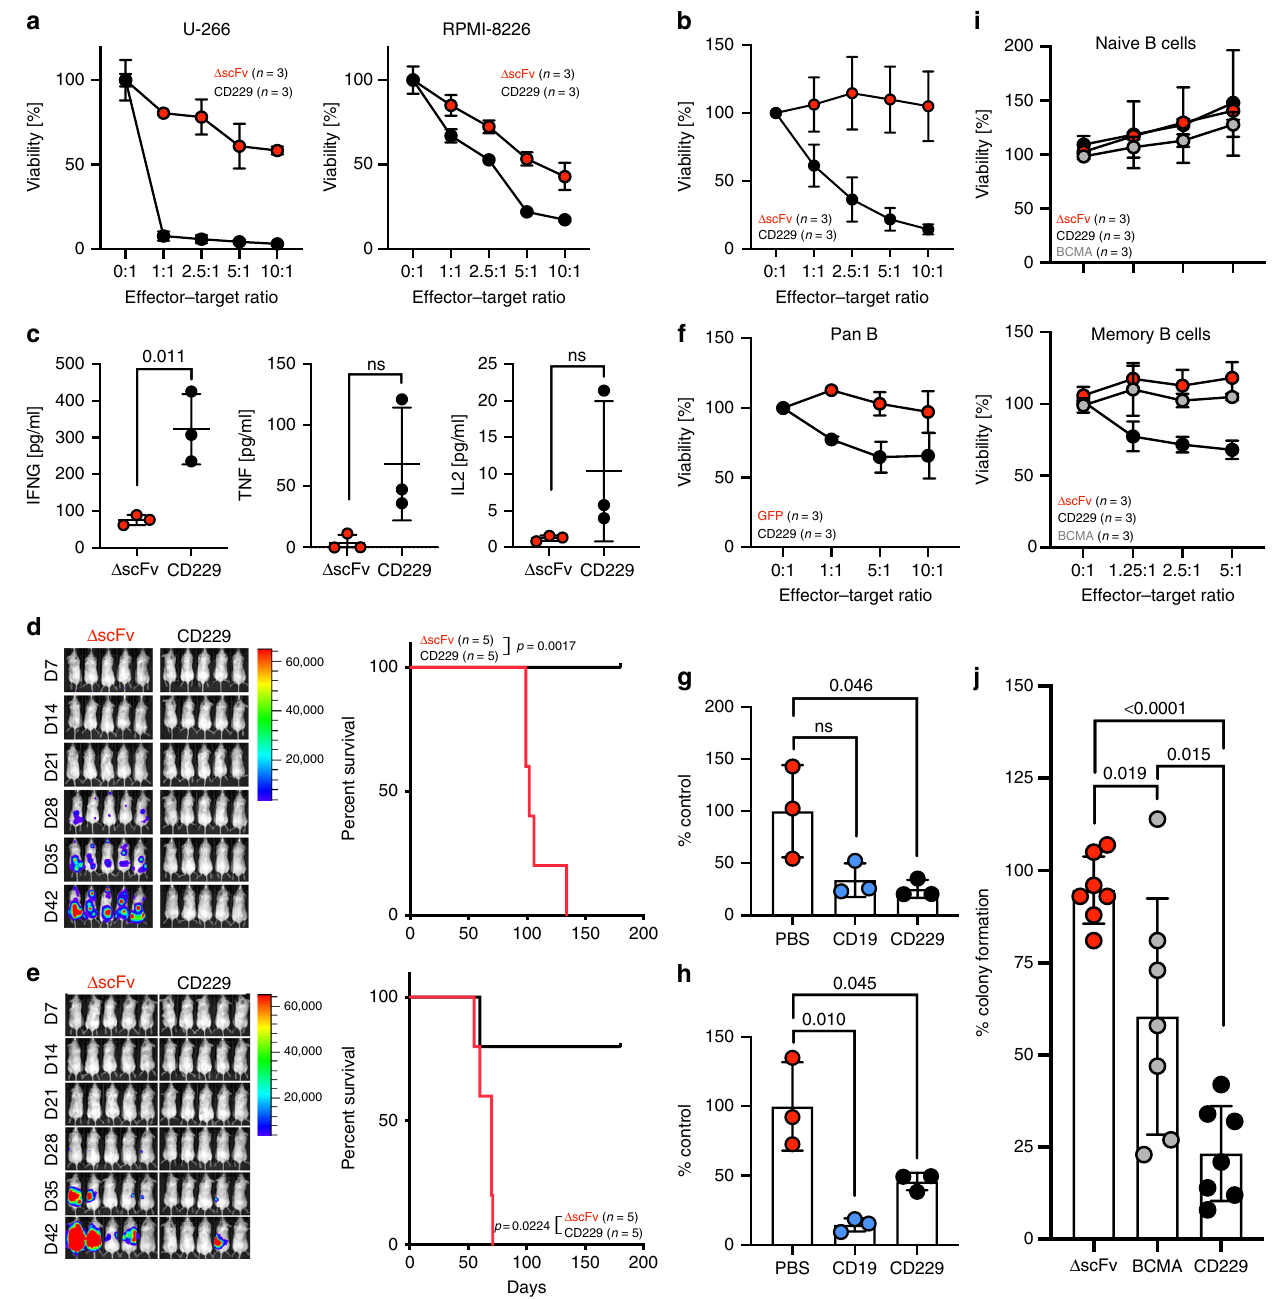
Fig. 4 CD229 CAR T cells target MM plasma cells and MM-propagating cells. a Killing of MM cell lines by CD229 CAR T cells or Δ scFv CAR T cells